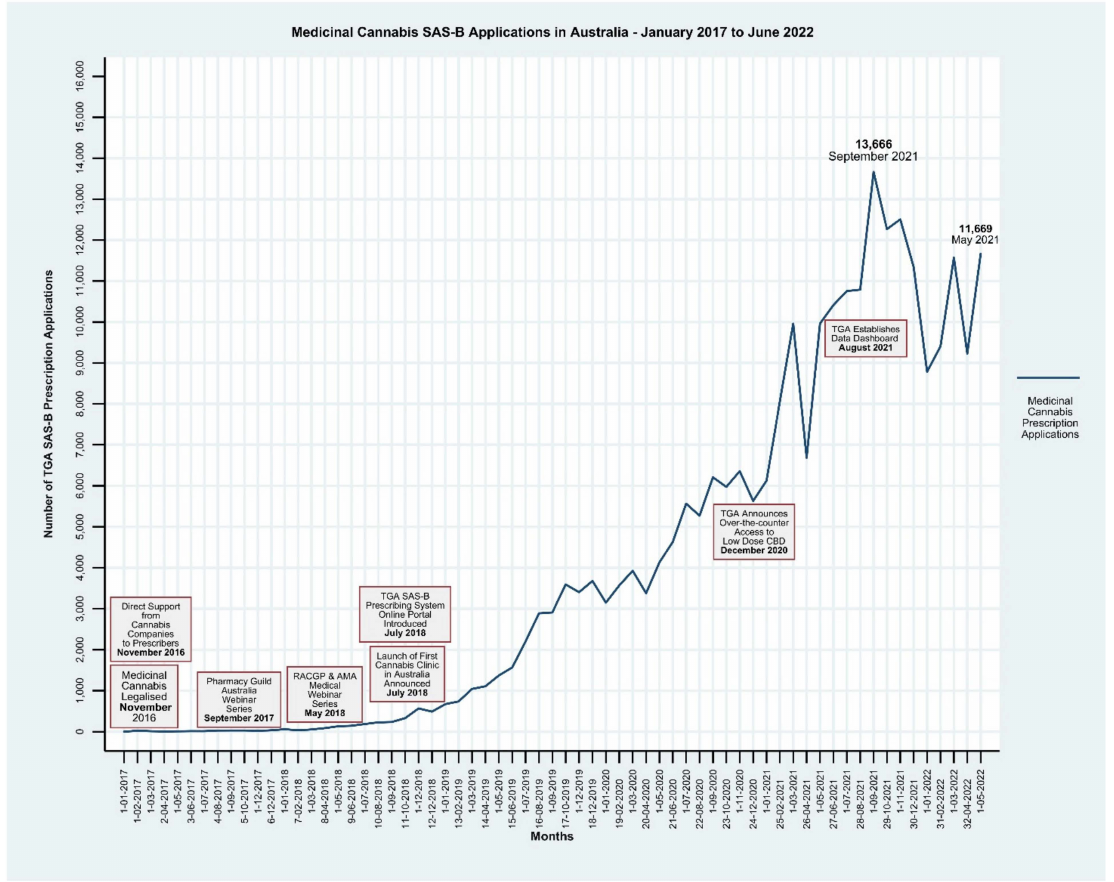
Figure 1. Medicinal cannabis in Australia